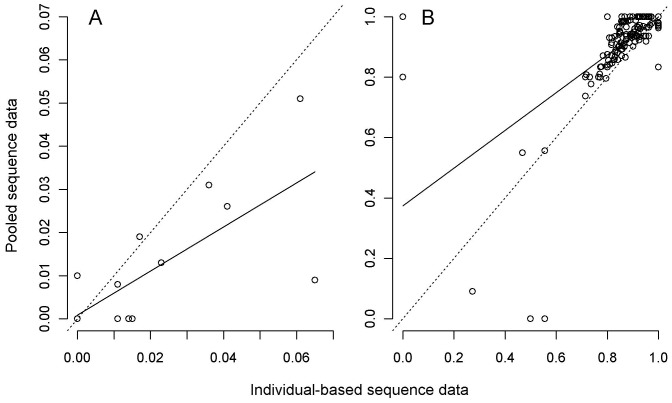
Relationship between pooled and individual approaches for estimating A) nucleotide diversity (π, N = 20 populations shown) and B) pairwise population differentiation (FST,
N = 190 population-pairs shown) from Leiopelma hochstetteri 570-bp Cyt b mtDNA data.The dotted lines are the expected relationship where β = 1 (i.e. the two approaches give identical estimates), the solid lines are the observed linear regression (Table 2).